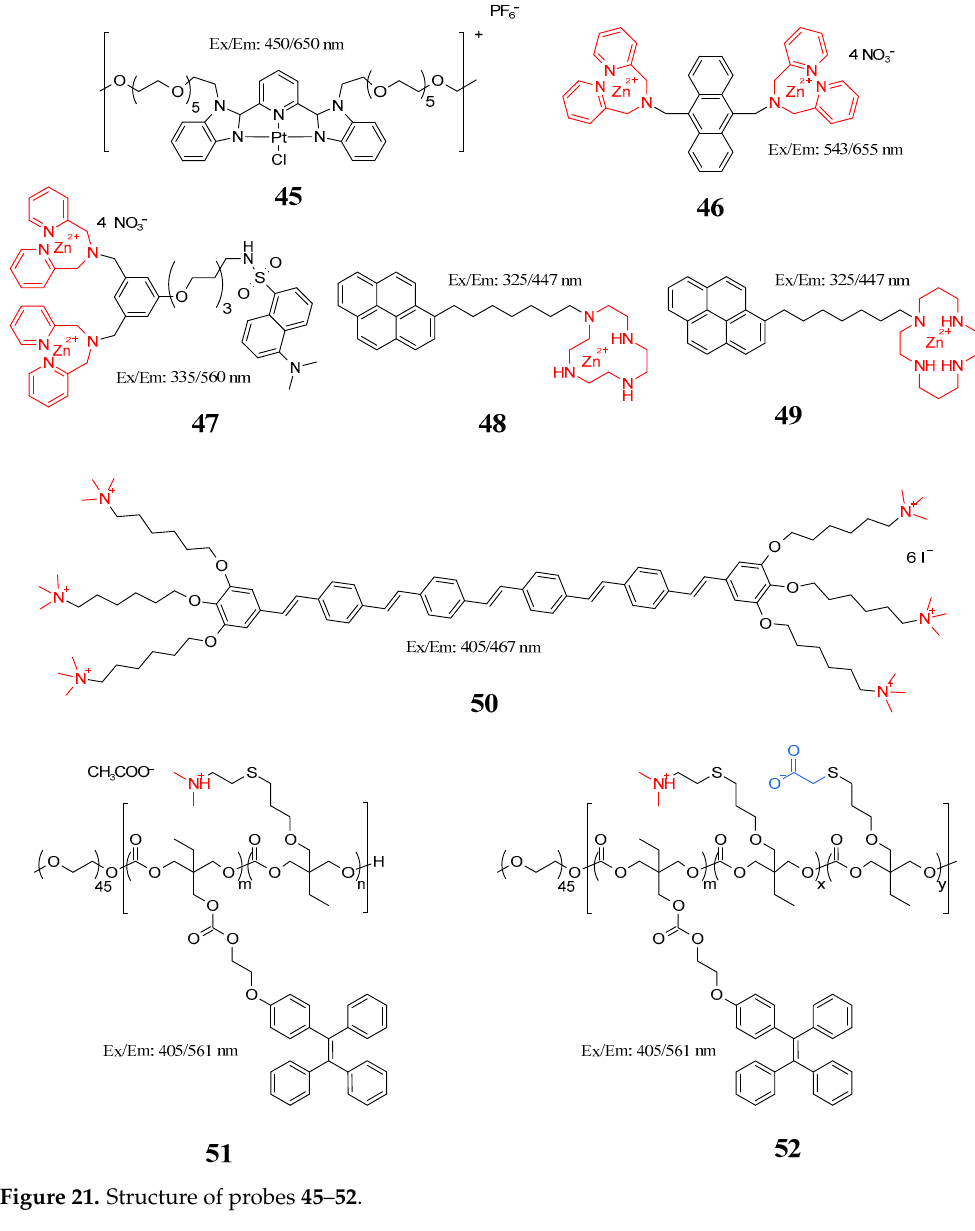
Figure 21. Structure of probes 45 – 52 .